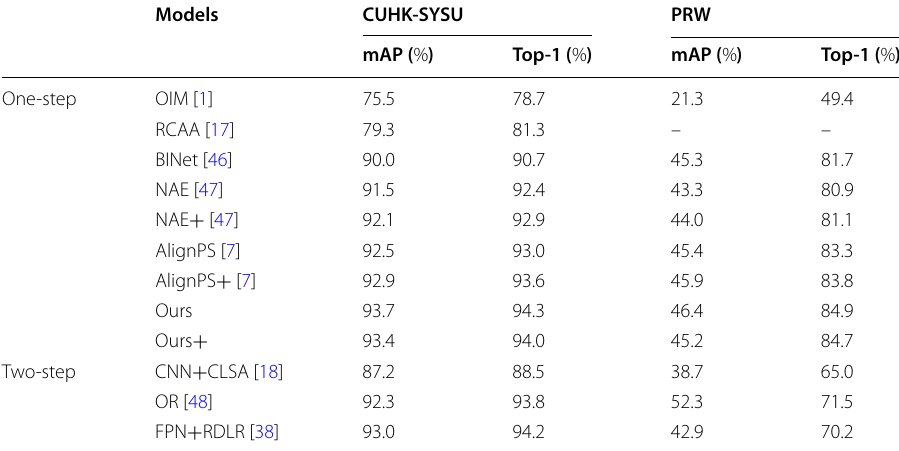
Table 3 Comparison of network models implemented on CUHK‑SYSU and PRW datasets for person search